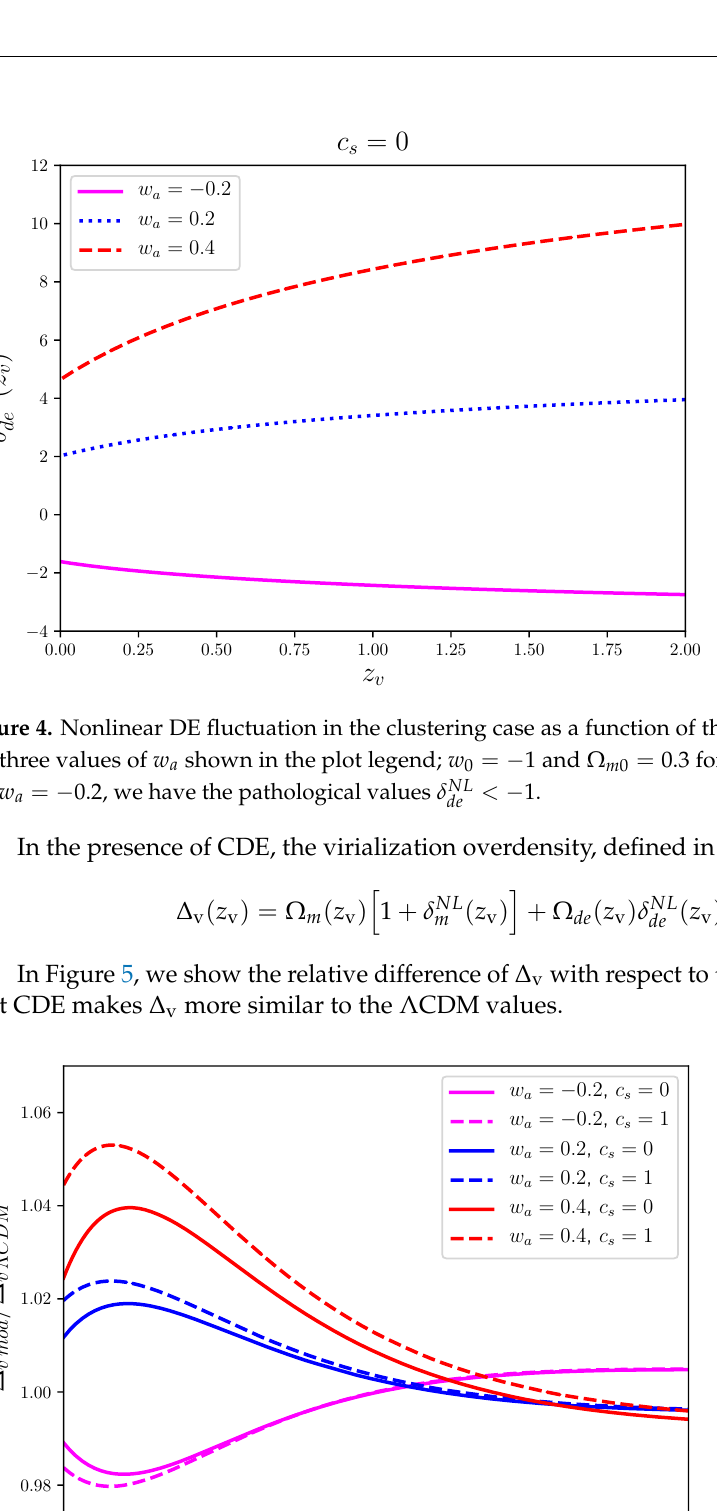
Figure 5. Ratio of ∆ v of a given model indicated in the legend to the corresponding Λ CDM value. In these examples, w 0 = 1 and Ω m 0 = 0.3 are −